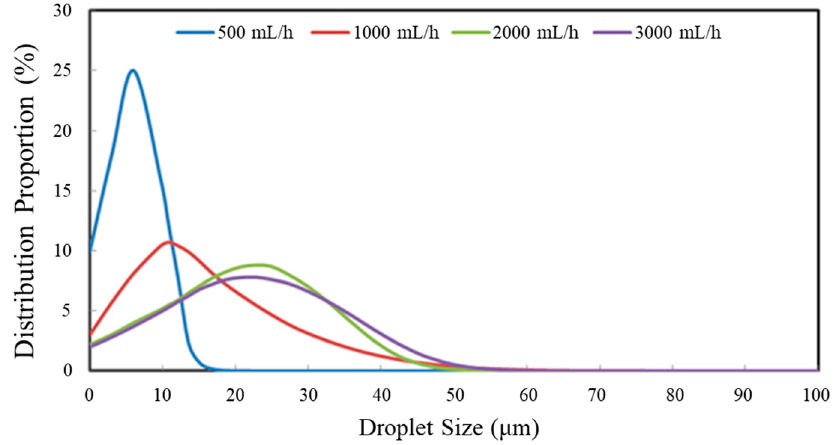
Figure 7. The droplet size distribution of di ff erent urea injection rates.